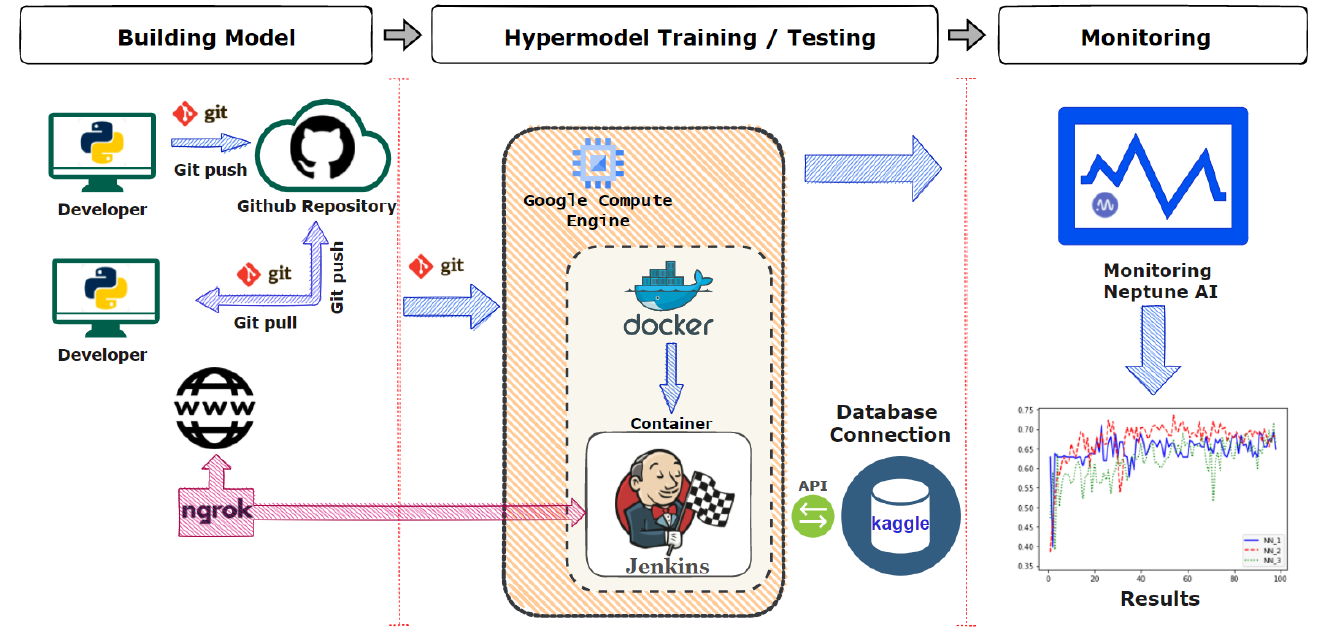
Figure 2. The proposed AutoML pipeline involves three stages: the Building Model stage, the Hypermodel Training/Testing stage, and the Monitoring stage, where each one of the above stages encompass several tasks implemented in sequence and in relation to the subsequent tasks.